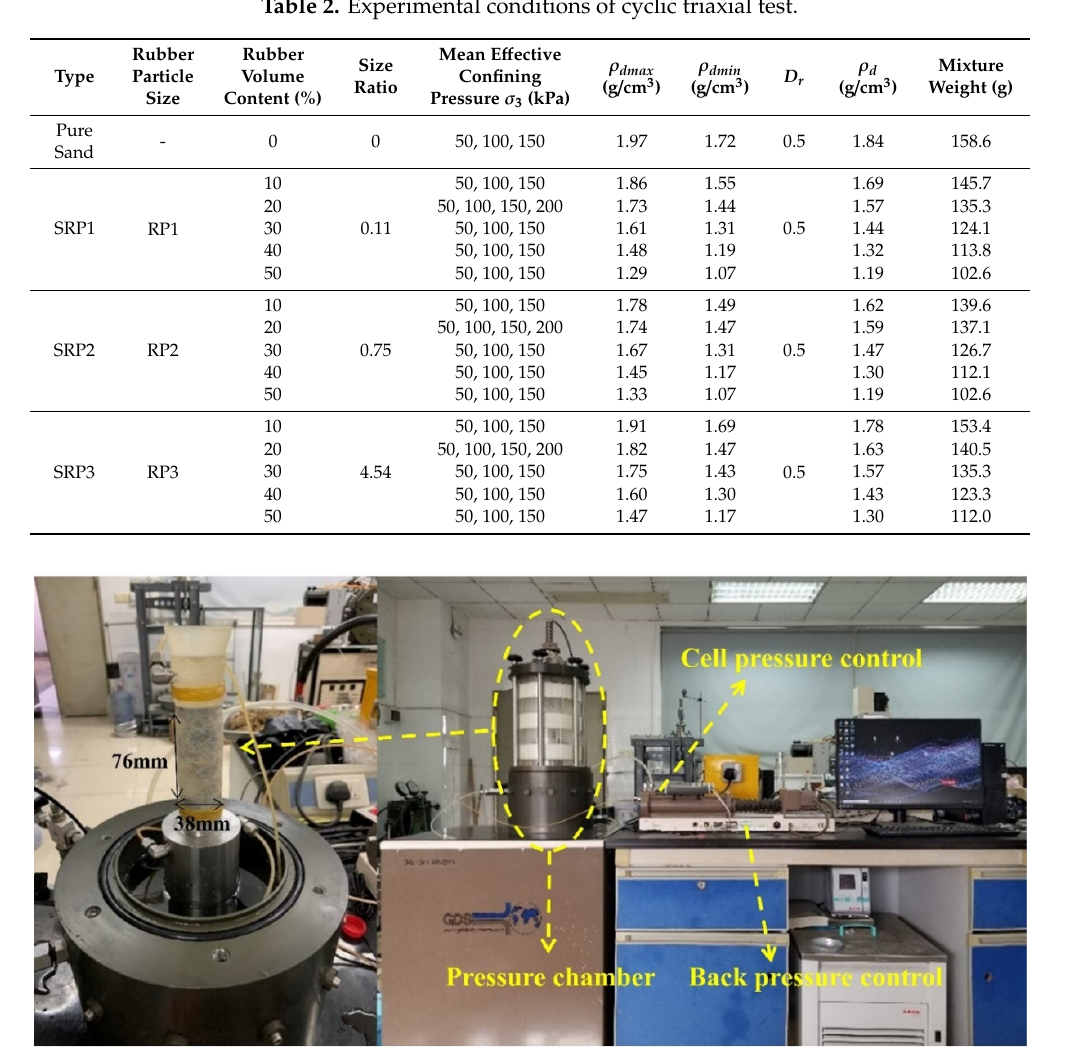
Figure 3. Typical sample diagram and experimental apparatus. Figure 2. Application diagram of multistage cyclic axial loading. Table 2. Experimental conditions of cyclic triaxial test.